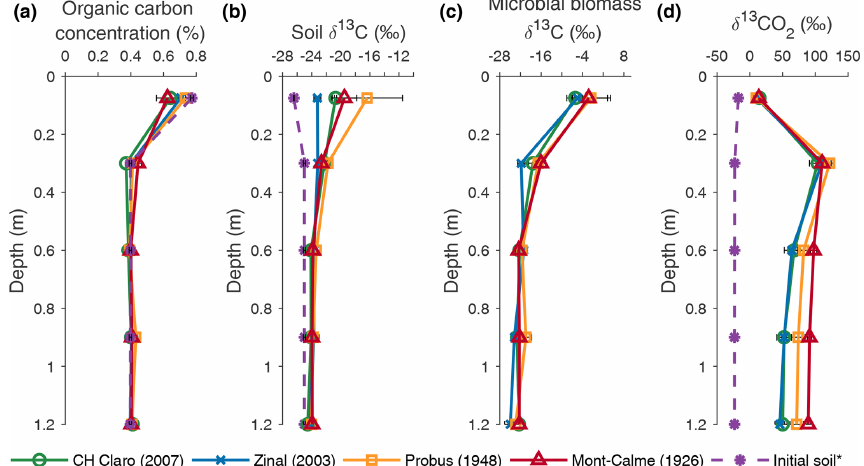
Figure 3. Depth profiles of organic carbon concentration (a) , the δ 13 C value of organic carbon (b) , the δ 13 C value of microbial biomass (c) and the δ 13 C value of soil CO 2 (d) , averaged per wheat cultivar at the end of the experiment. Error bars represent the standard error ( n = 3). ∗ The initial soil indicates measurements performed on the soil that was used to fill the lysimeters prior to the experiments in (a) and (b) and measurements of the δ 13 CO 2 depth profile at the beginning of the experiment in (d) .